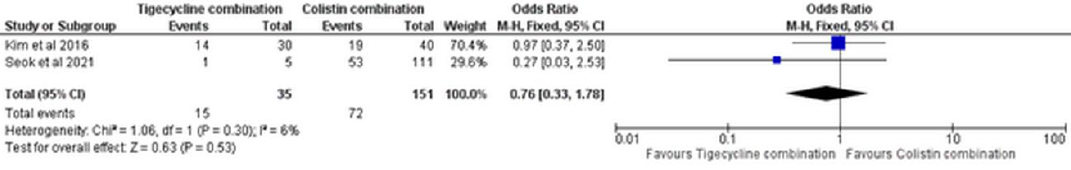
Figure 9. Clinical response of tigecycline combination versus colistin combination